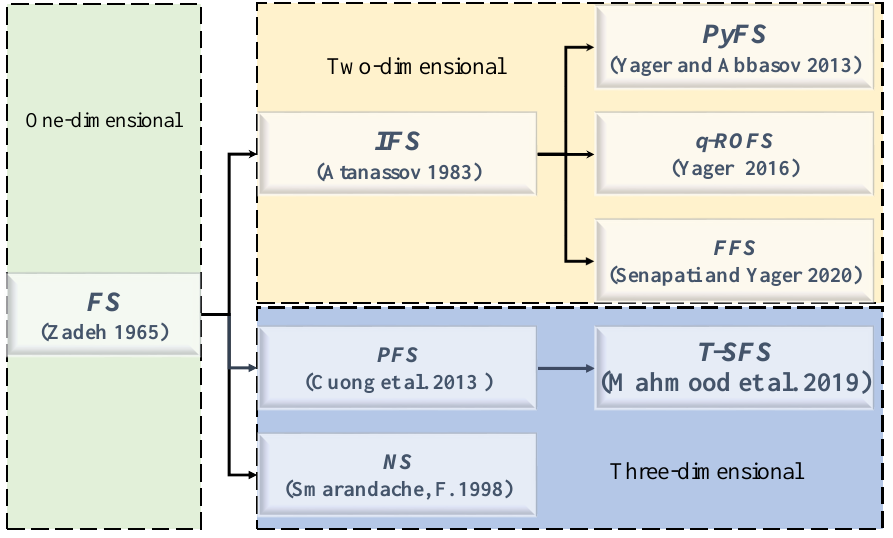
Figure 1. Dimension-Based Fuzzy Set Classification